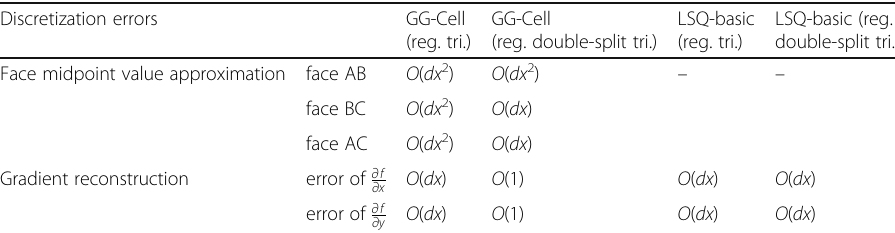
Table 3 Discretization errors of gradient reconstruction and face midpoint value approximation Discretization